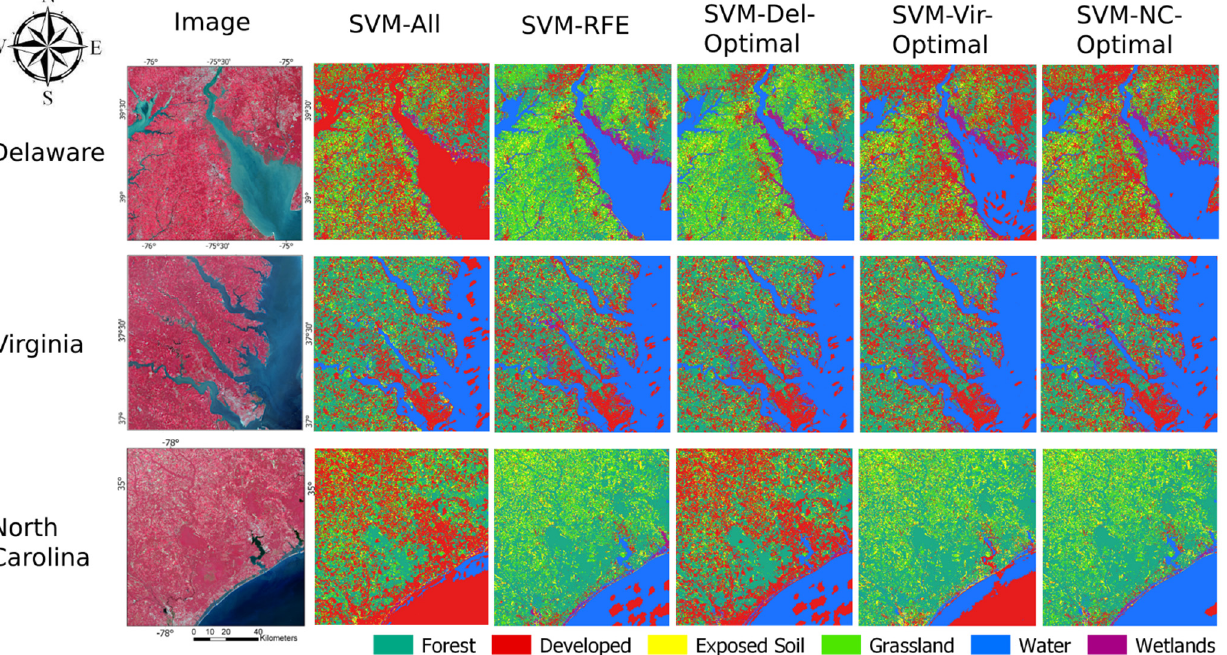
Figure 7. Example set of land cover classifications of the Delaware, Virginia, and North Carolina datasets trained from the small training sets using a variety of feature sets, including the full feature set (SVM-All), SVM-RFE, SVM-Del-Optimal, SVM-Vir-Optimal, and SVM-NC-Optimal. The Sentinel-2A imagery is displayed as a false-color composite with bands 8 (NIR), 4 (red), and 3 (green) depicted as RGB.